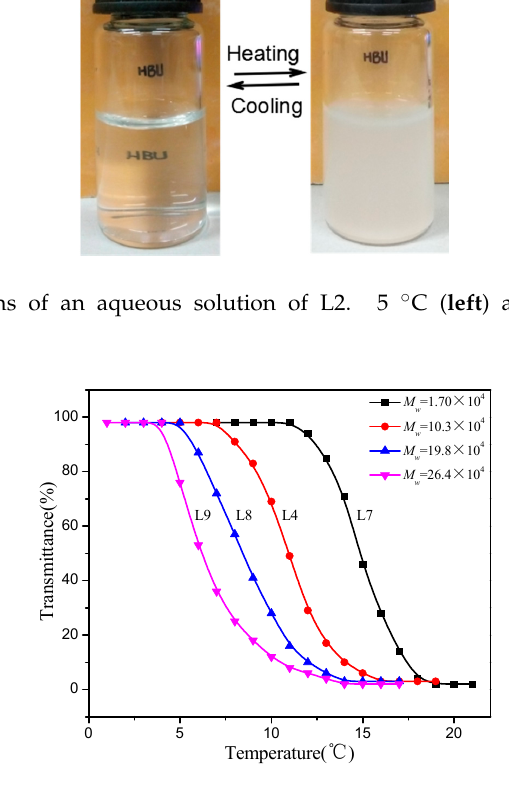
Figure 8. The curves of transmittance versus temperature of L4, L7, L8 and L9. Solution concentration: 3 mg·mL − 1 ; heating rate: 0.1 °C ·min − 1 ; pH = 7.